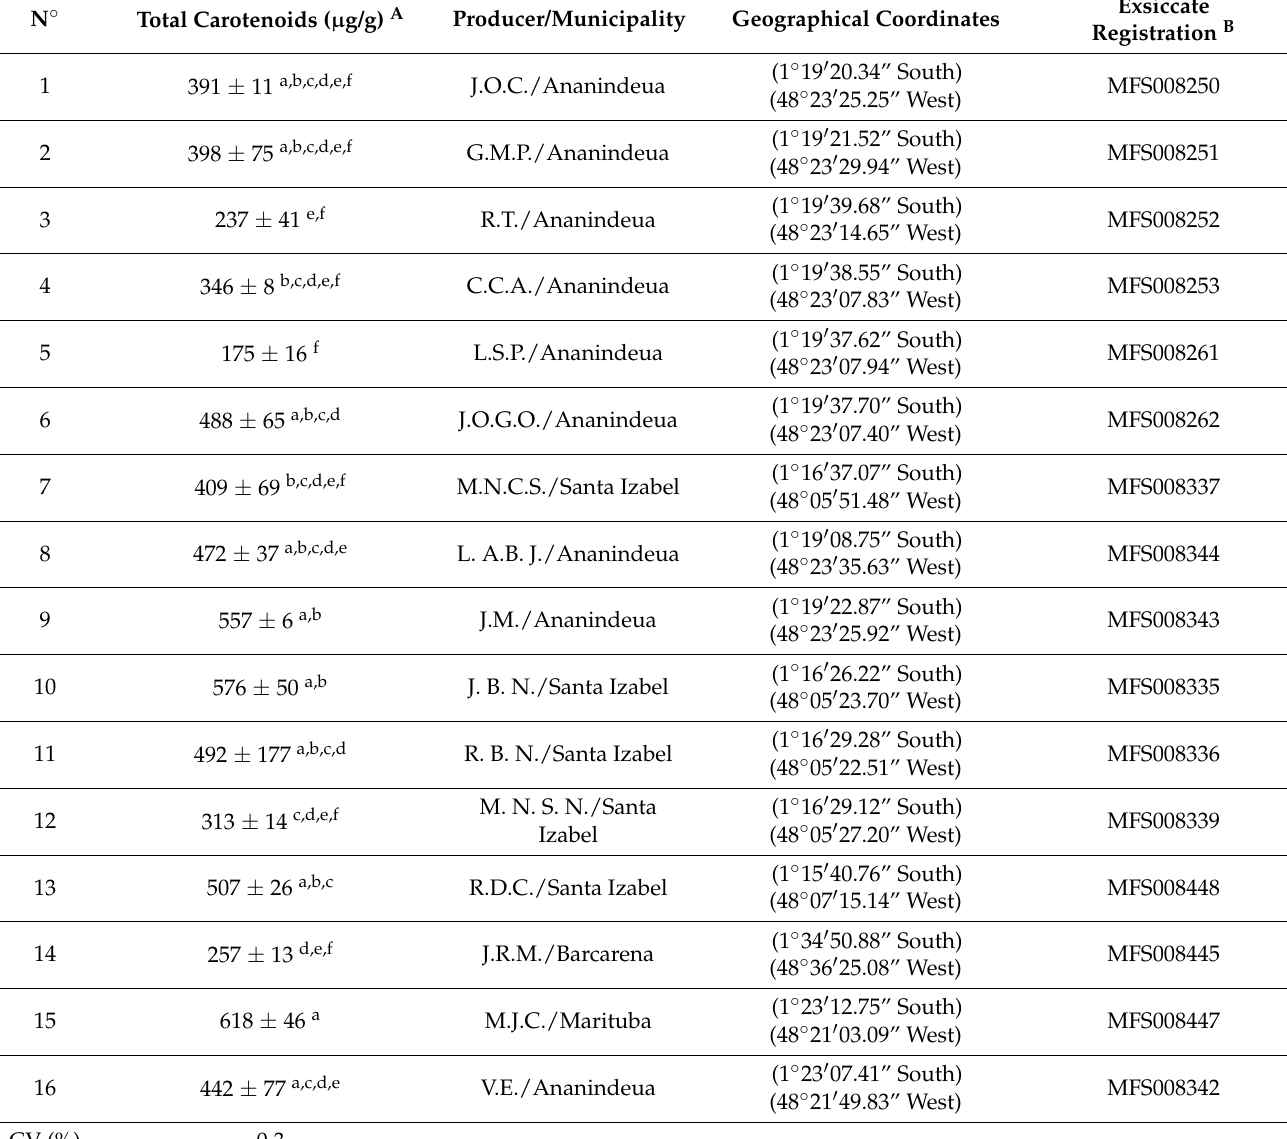
A Values with different letters in the same column show a significant difference ( p ≤ 0.05) and the means were obtained from three independent extraction procedures ( n = 3); B All exsiccates were performed in duplicates. Lowercase letters (a, b, c, d, e, f) represent statistical differences between column